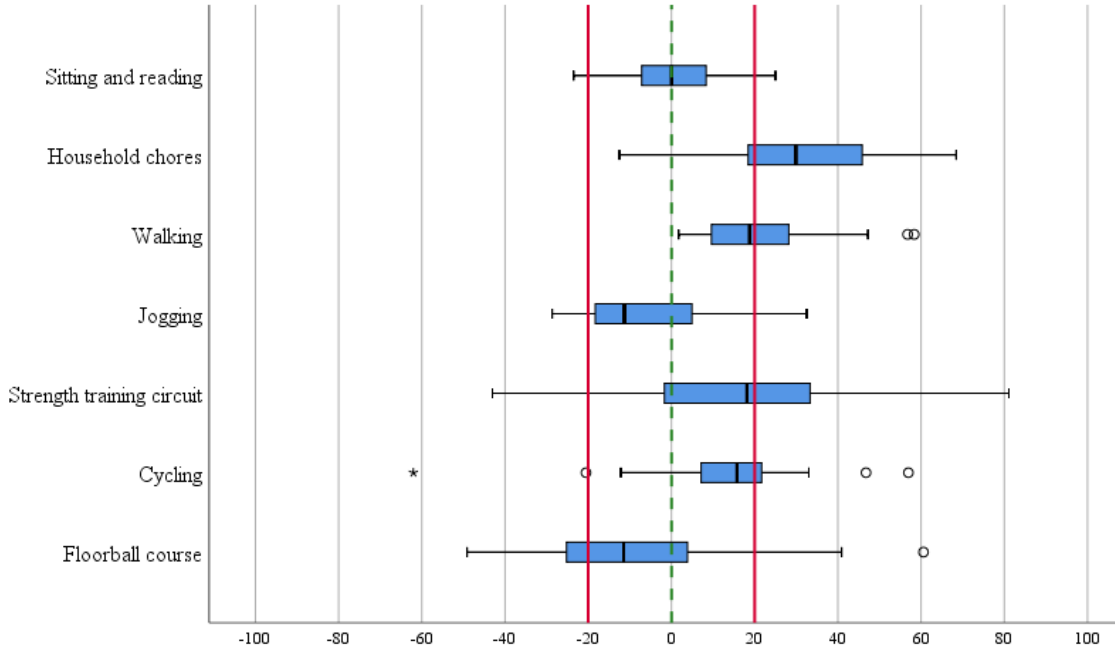
Figure 2. Relative deviation of the energy expenditure (EE) estimation by the Polar Vantage M compared with the criterion measurement of the MetaMax 3B separated for each activity task. The red lines indicate the proposed equivalence zone (SD 20% of the mean); the lower and upper boundary of the boxplots indicate the 25% and 75% quantiles of EE data, respectively, and the middle notch indicates the median data value. The whiskers include all data points that fall within the 1.5 interquartile range of the 25% and 75% quantile values. Circles and stars indicate EE data points that lie beyond the 1.5 and 3 interquartile ranges,